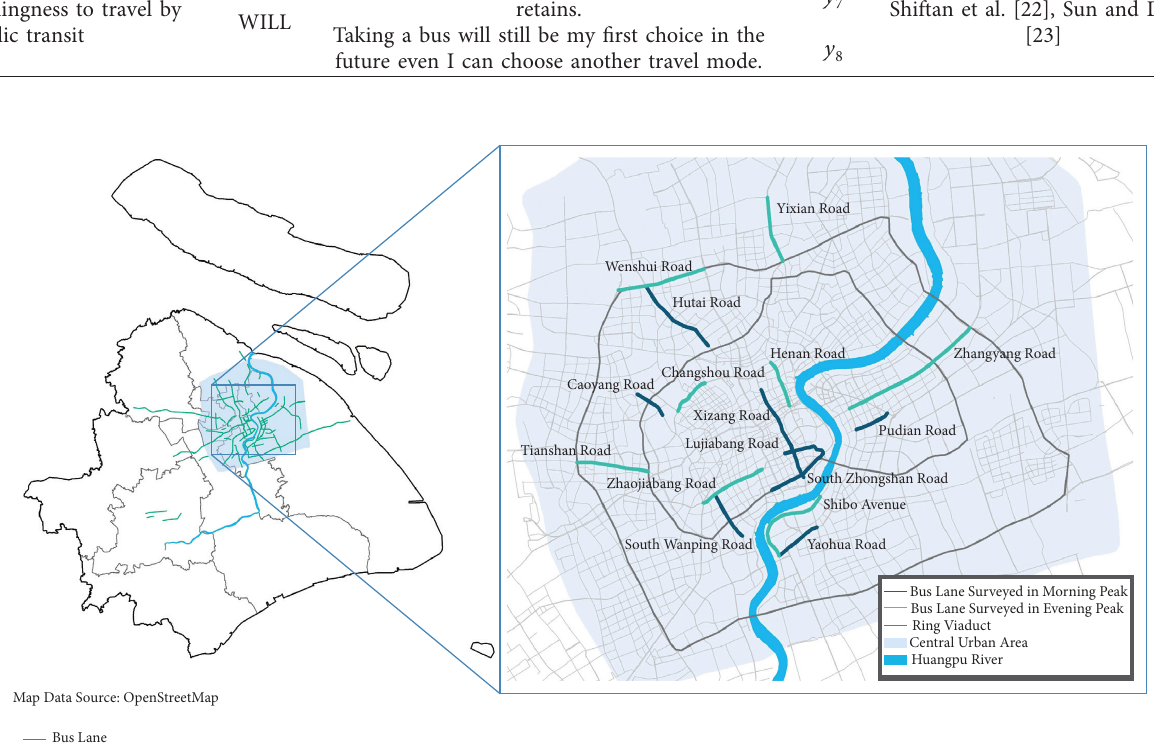
Figure 2: Locations and survey time of selected bus lanes.